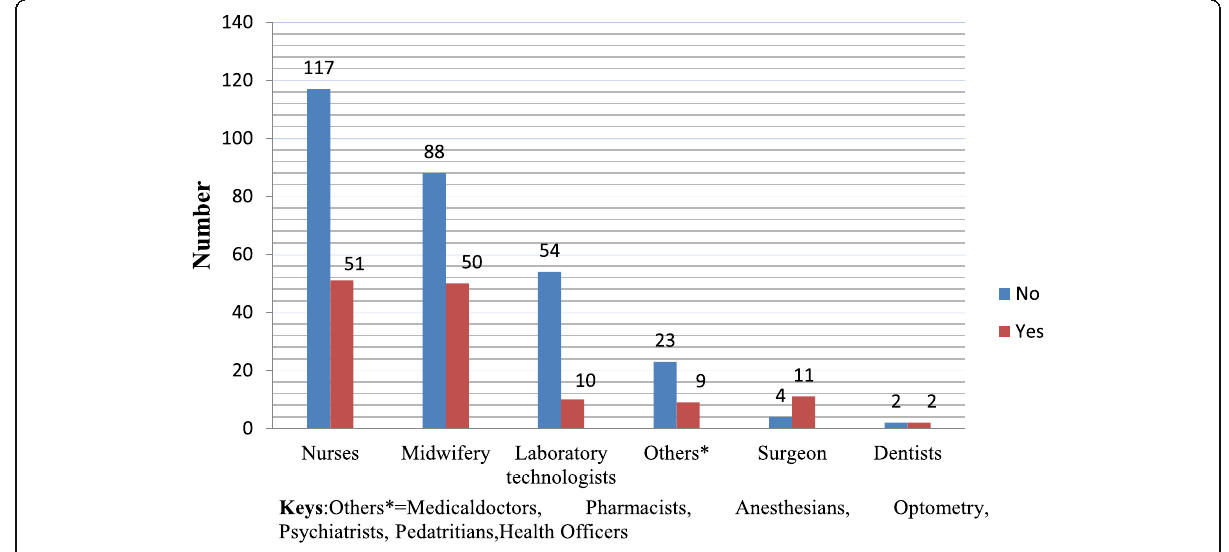
Fig. 2 Distribution of occupational contact dermatitis by profession, Gondar town, Ethiopia, 2018 ( N =